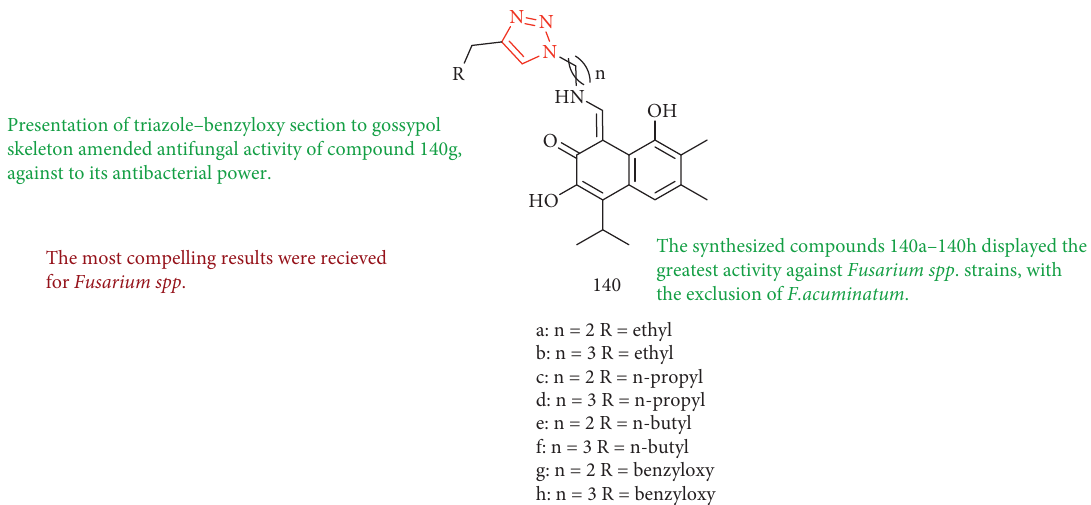
Figure 73: Chemical structure of new gossypol-triazole conjugates including aliphatic chains and benzyloxy